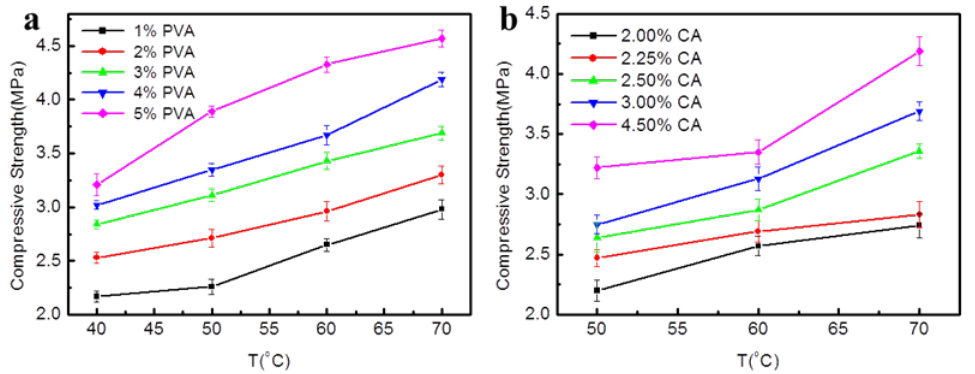
Figure 5. Effect of preparation conditions on compressive properties of consolidated soil columns Preparation conditions of KGM/CA/PVA ternary blend adhesive: the content of KGM was 4.5%, the pH value is 5.0, pH of cinnamon soil was 8.5; Particle size of soil was 1 mm. ( a ) The content of the CA was 4.5%; ( b ) The content of the PVA was 4.0%.